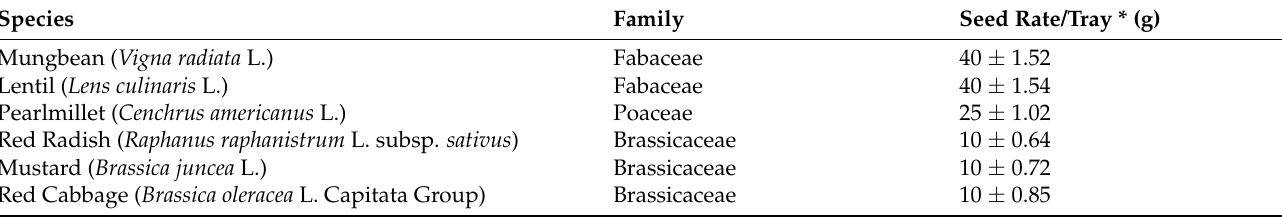
Table 1. Details of the crop species which are used as microgreens. Species Family Seed Rate/Tray * (g) Mungbean ( Vigna radiata L.) Fabaceae 40 ± 1.52 Lentil ( Lens culinaris L.) Fabaceae 40 ± 1.54